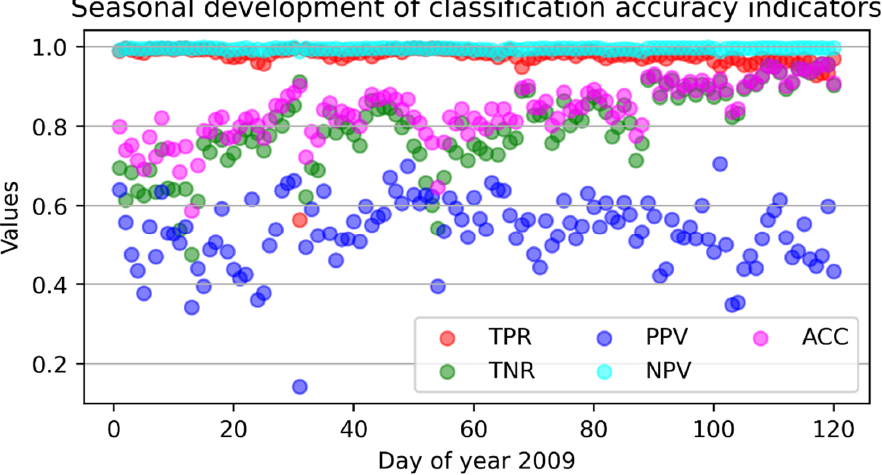
Figure 9. The development of classification accuracy indicators over the months January to April 2009 (i.e., the first 120 days of the year). While no seasonality was found for the positive predictive value (PPV) indicator, it exists for true negative rate (TNR) and accuracy (ACC). There is an increase in both over time. On the one hand, this is due to the general decrease in snow cover, but on the other hand, it is also due to its better detection. So, it is worth having a closer look at the difference grids for the lowest and highest values of TNR, PPV, and ACC, respectively. The date 13 January 2009 stands out as a negative example, as this is when TNR, PPV, and ACC reach their lowest values. Figure 10 shows the misclassifications.